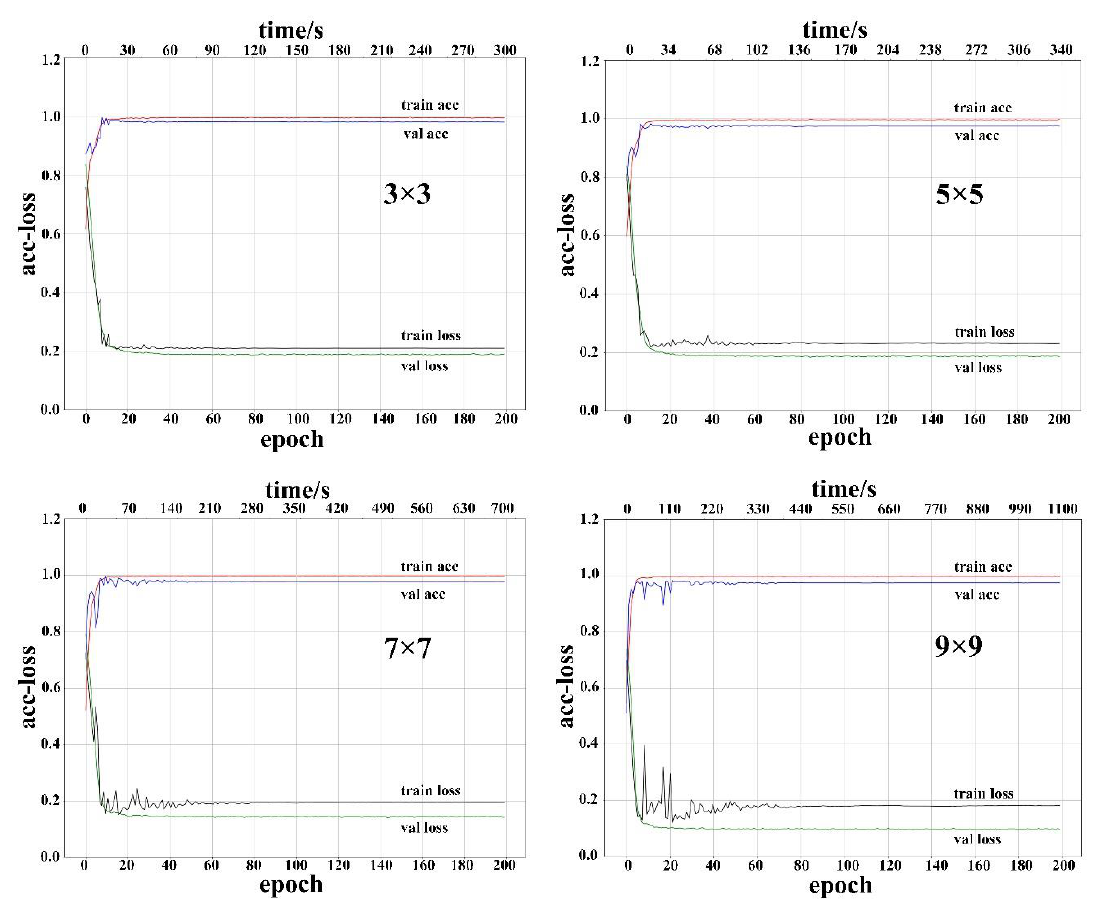
Figure 7. Accuracy and loss in the training processes using different sizes of image patches. “Acc” and “val” mean accuracy and validation, respectively.